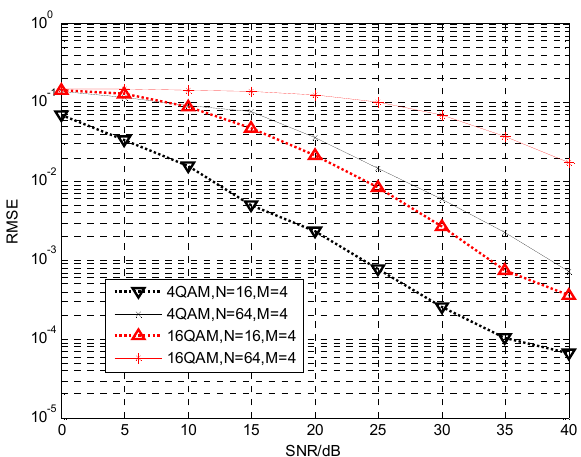
Figure 6. RMSE performance of subspace blind method for different modulation and different number of N , with M = 4, N s = 200.